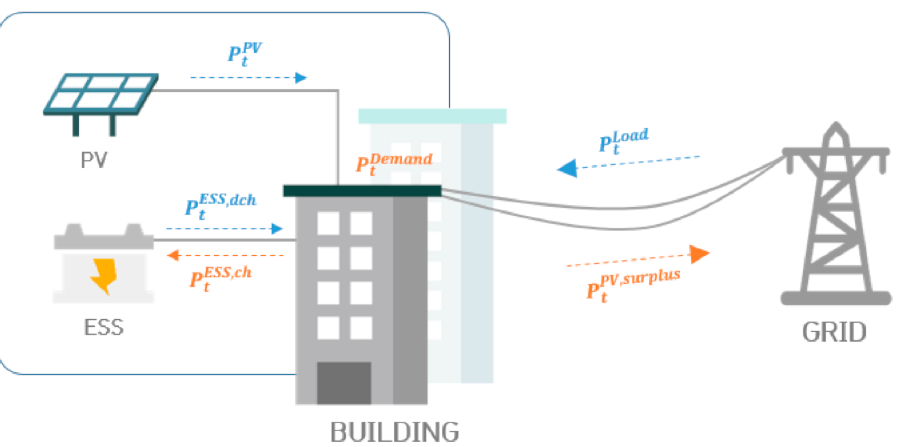
Figure 2. DER structural diagram for buildings considered in this